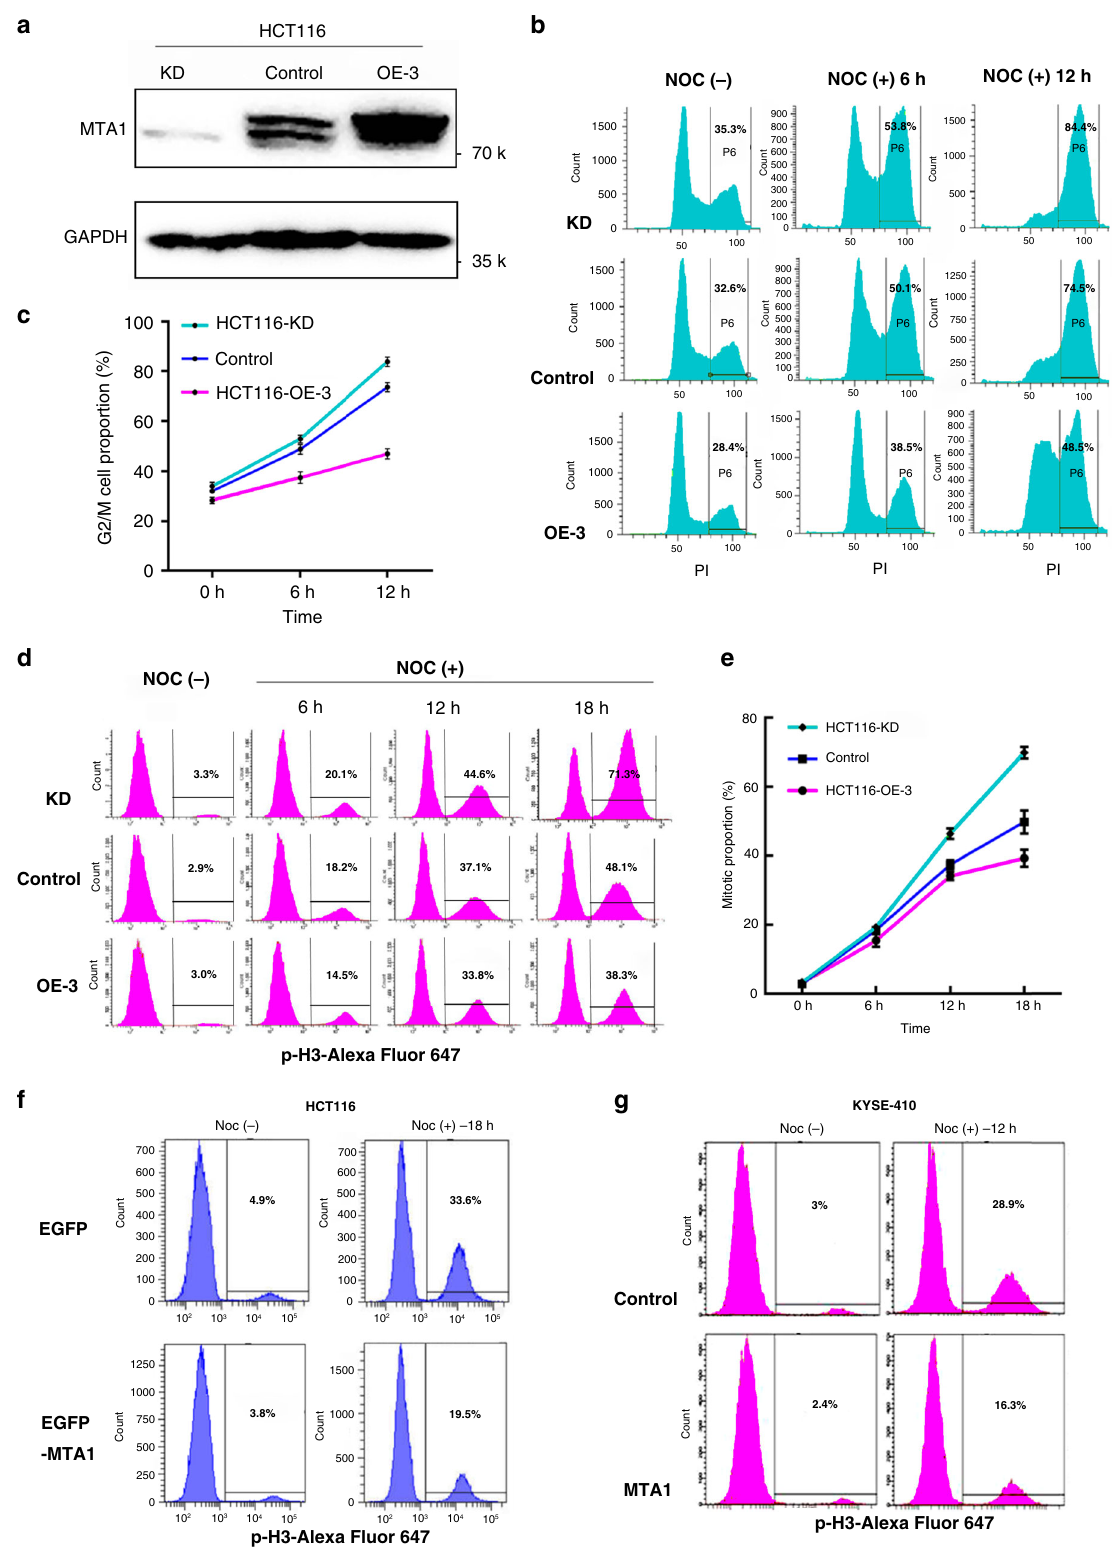
pulmonary metastases (2/6, 33.3%) in a nude mouse xenograft model, which were not found in the control mice (0/6, 0%) (Fig. 7g). In sphere formation assay, the MTA1-overexpressing cells formed more single cell-derived spheres with a larger, rounder and more compacted morphology through day 1 to day 8